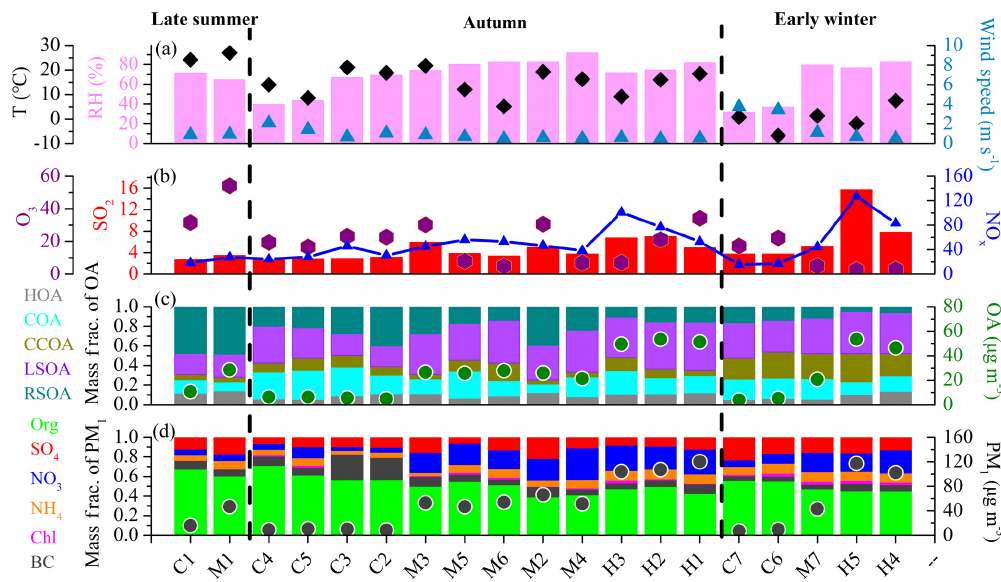
Figure 5. Summary of (a) meteorological parameters (RH, T , WS), (b) gaseous species (SO 2 , NO x , O 3 ), (c) OA factors and (d) PM 1 composition for episodes C1–C7, M1–M7 and